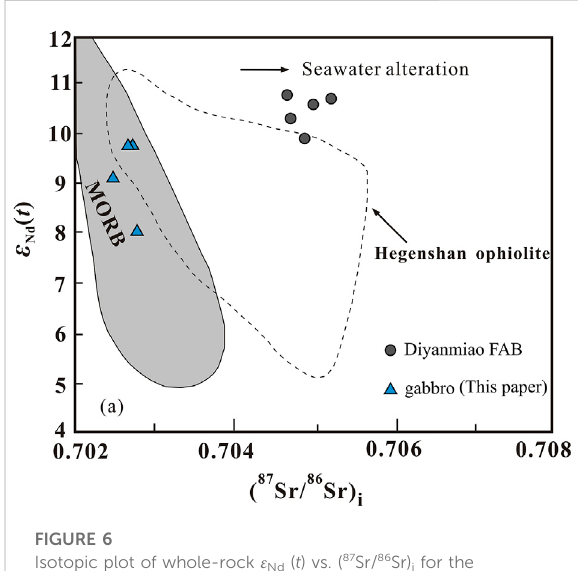
FIGURE 6 Isotopic plot of whole-rock ε Nd ( t ) vs. ( 87 Sr/ 86 Sr) i for the gabbrointheDiyanmiaoophiolite;Datasources:Miaoetal.(2008) for the fi eld of Hegenshan ophiolite; Li et al. (2020a) for Diyanmiao